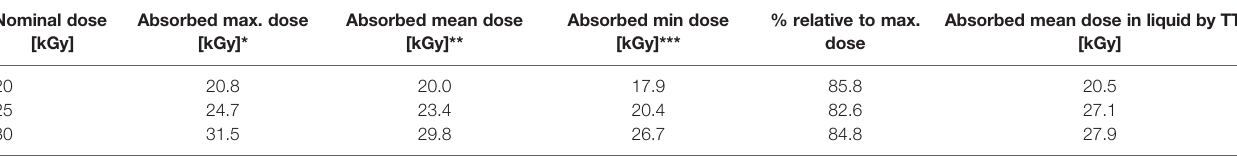
TABLE 1 | Depth dose pro fi le derived from Risø B3 fi lms stacked within the OPP-system. Nominal dose [kGy]